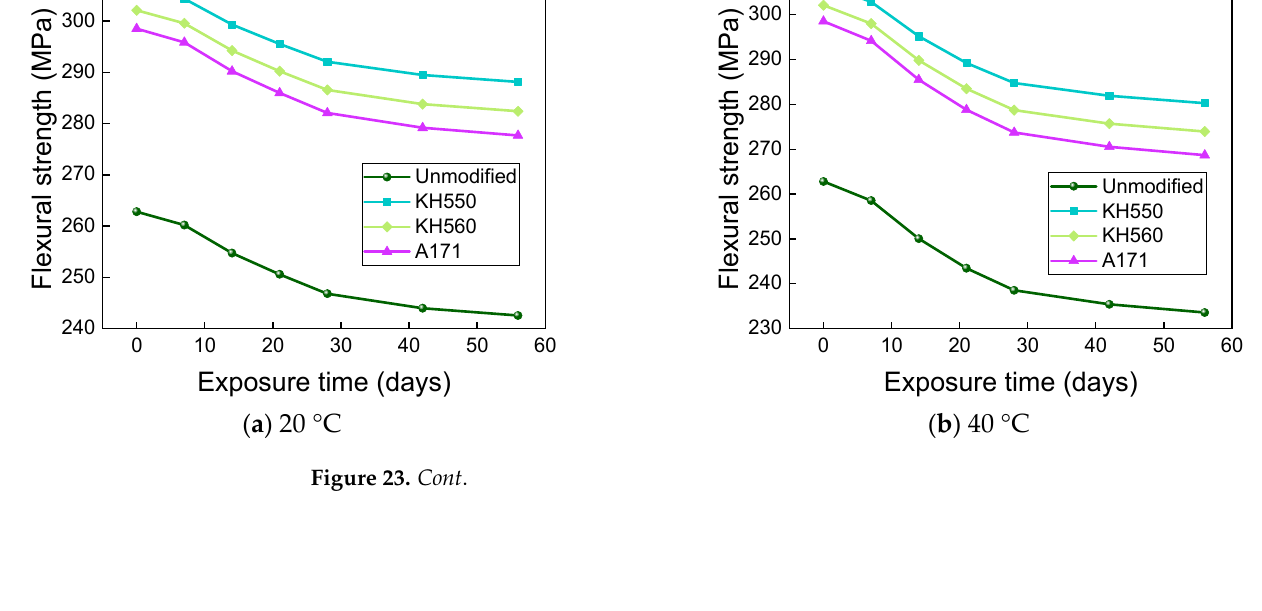
( c ) 60 °C Figure 23. Flexural strength in a 10% NaCl high-concentration seawater environment. 0